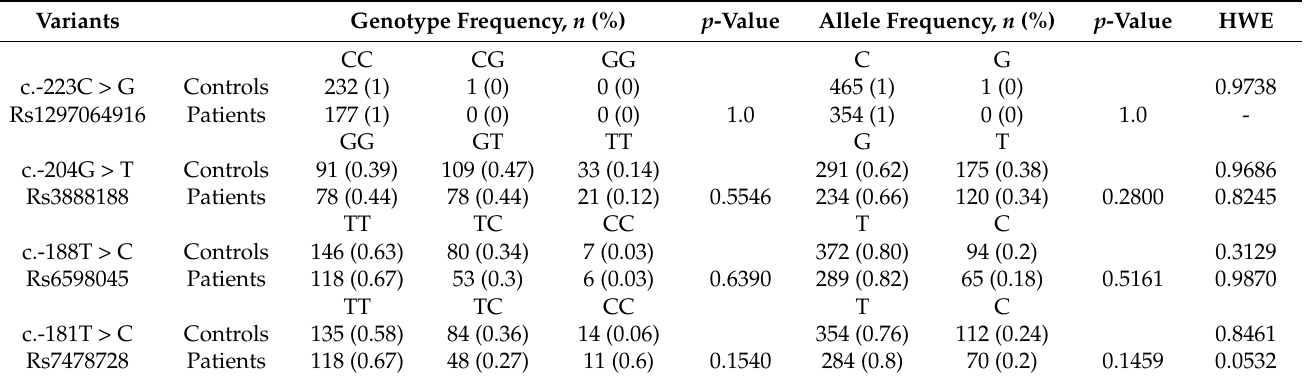
Table 2. Comparison of genotype and allele frequencies between healthy controls and Alzheimer’s disease (AD) patients in a Korean